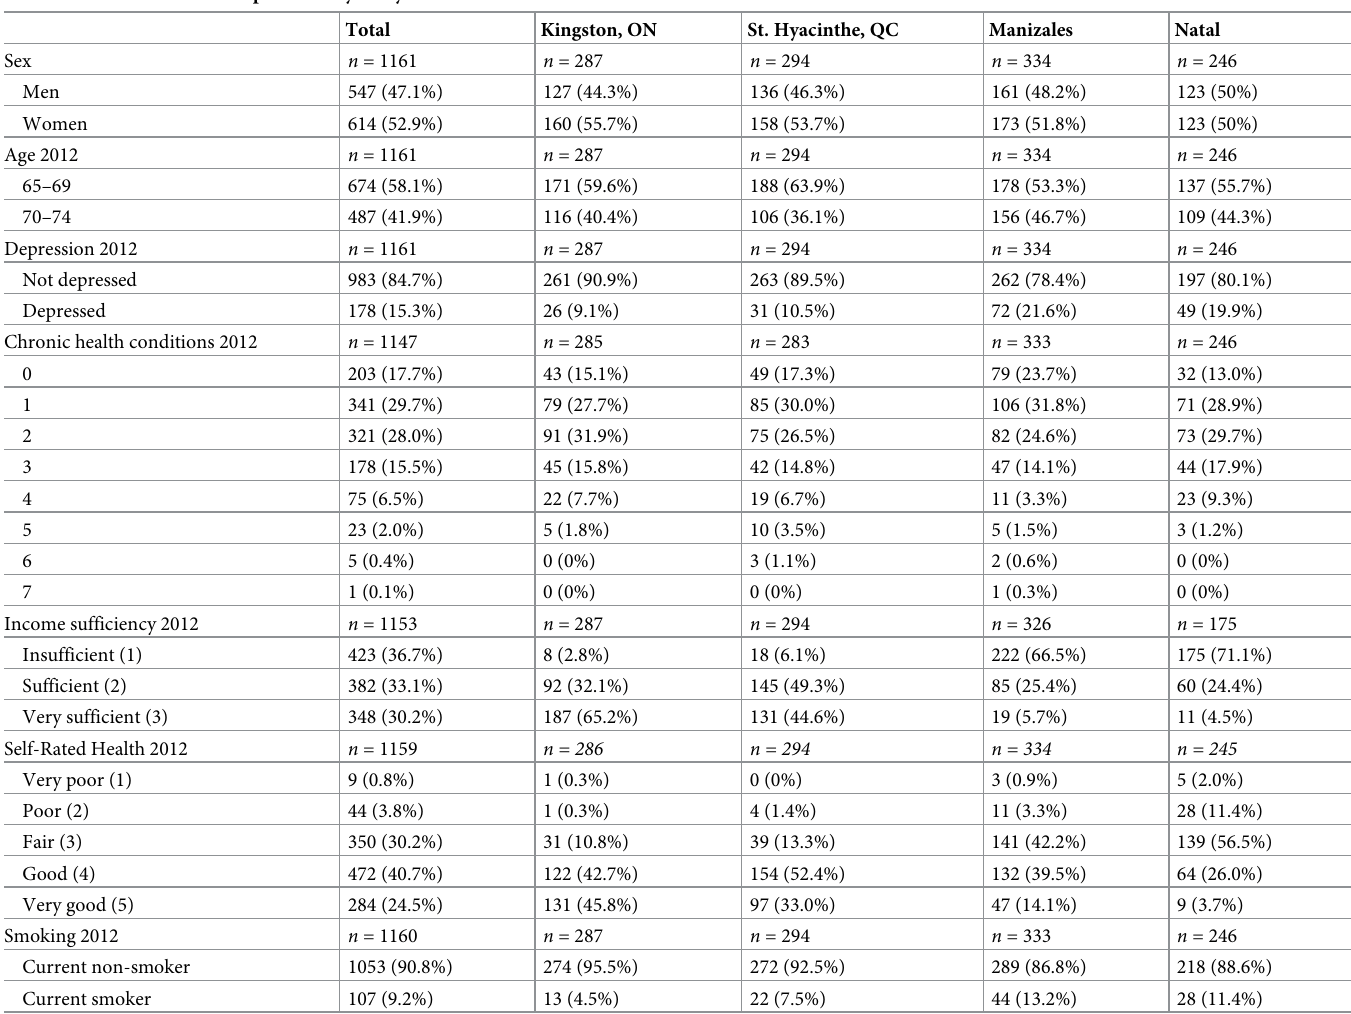
Table 1. Characteristics of respondents by study